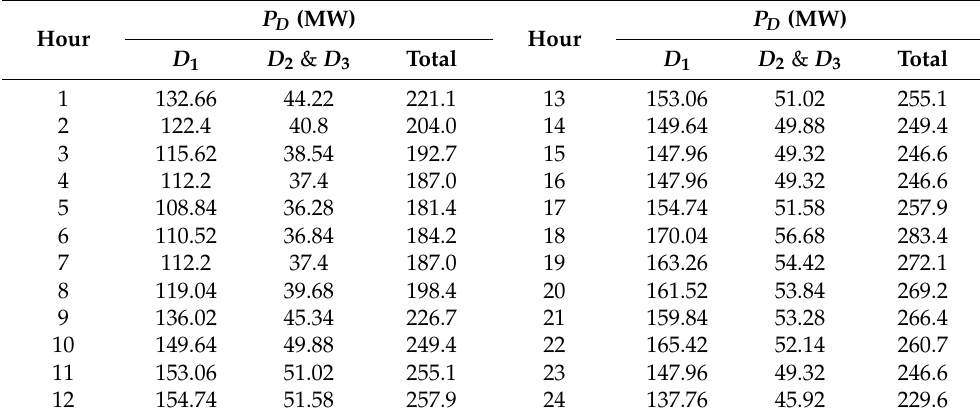
Table 3. Hourly load power demand for 24 h.